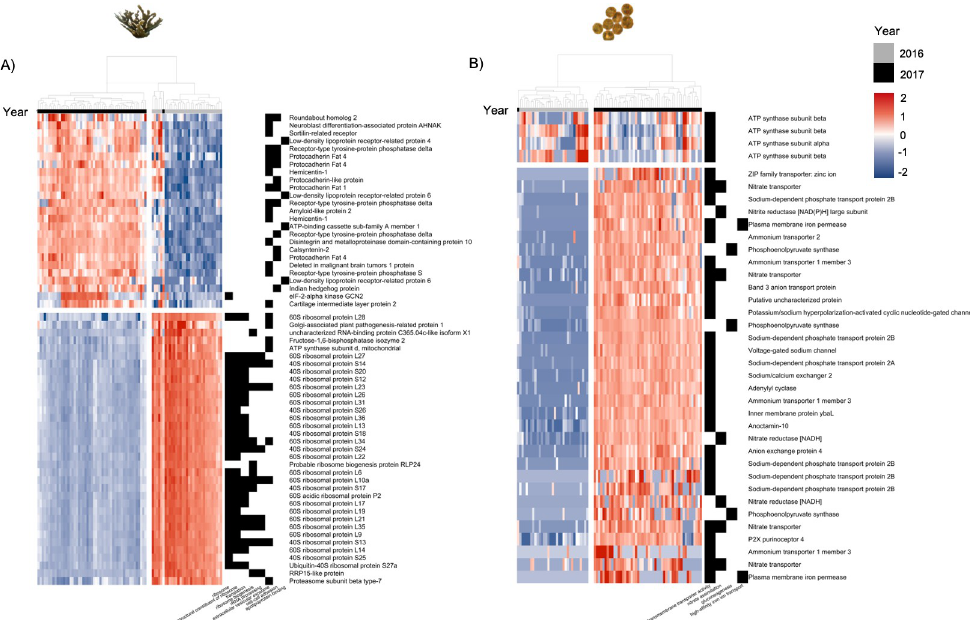
Fig 3. Genes driving the difference between 2016 and 2017 responses in the coral host and Symbiodiniaceae. A) Coral host genes linked to significantly enriched gene ontology (GO) terms, identified from principal component (PC) 1 loadings. Genes are linked to translation and ribosomal formation processes. Hierarchical clustering of the samples (heatmap columns) shows grouping between the samples from 2016 (grey) and 2017 (black), with 2016 genes having higher normalized expression and 2017 having lower normalized expression. B) Symbiodiniaceae genes linked to significantly enriched GO terms identified from PC1 loadings. Genes are linked to transmembrane ion transport processes. Hierarchical clustering of the samples (heatmap columns) shows grouping between the samples from 2016 (grey) and 2017 (black). For A) and B), grey = 2016 samples, black = 2017 samples. Left heatmap shows higher (red) to low (blue) gene counts using a variance stabilizing transformation. Right heatmap is presence (black) and absence (white) of genes to GO terms. Column dendrogram shows hierarchical clustering of samples. Rows (genes) also arranged using hierarchical clustering with dendrogram